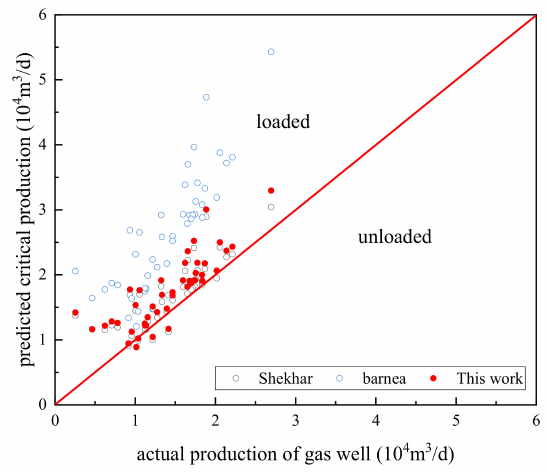
Figure 16. Comparison of prediction results of each model (Coleman well).